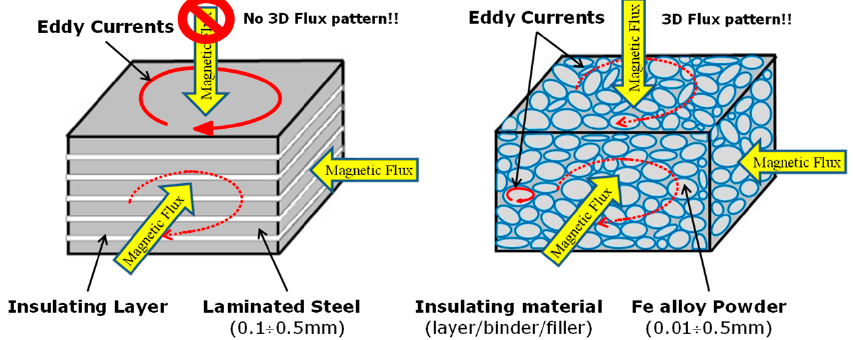
Figure 1. The magnetic behavior difference between lamented steel and SMC materials: magnetic flux preferential directions and eddy-current paths.